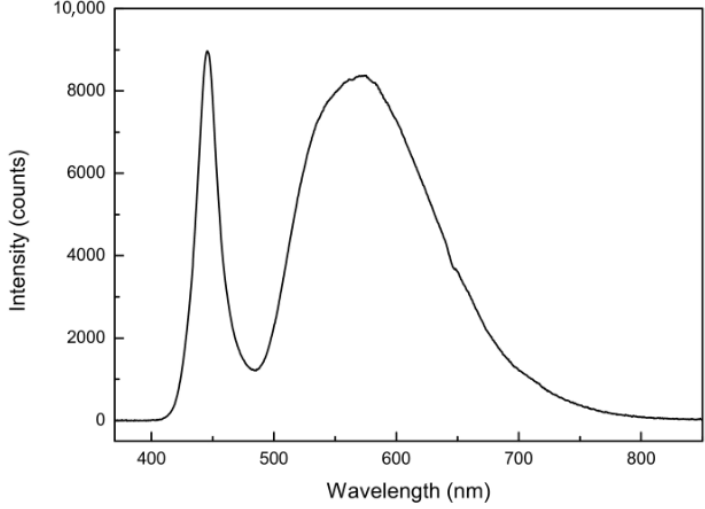
Figure 4. Light intensity spectrum of the white LED used in this study. Table 1. Characteristics of the spectrometer used, as provided by the manufacturer (Hamamatsu) [1,29].